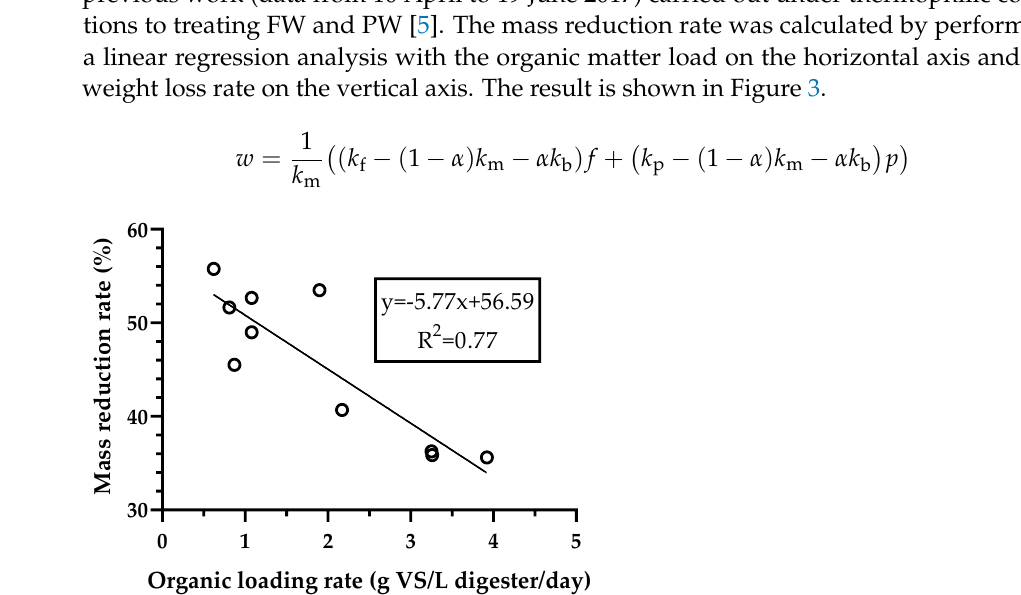
Figure 3. Linear relationship between mass reduction rate and organic loading rate based on previous data.